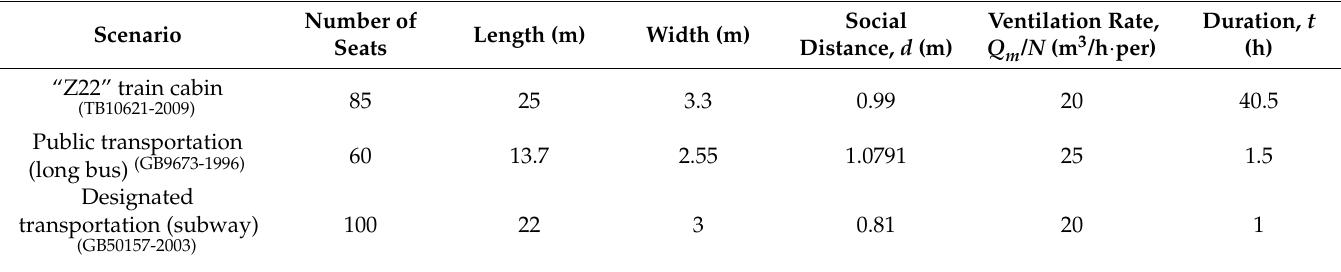
Table 3. Parameters of confined indoor environment used in the Wells-Riley model.